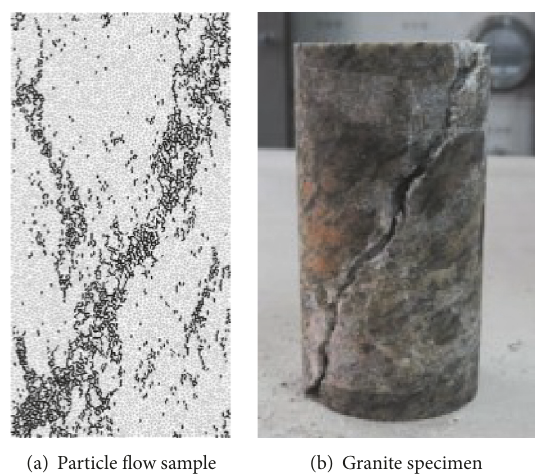
Figure 2: Stress-strain curves under different confining stresses.